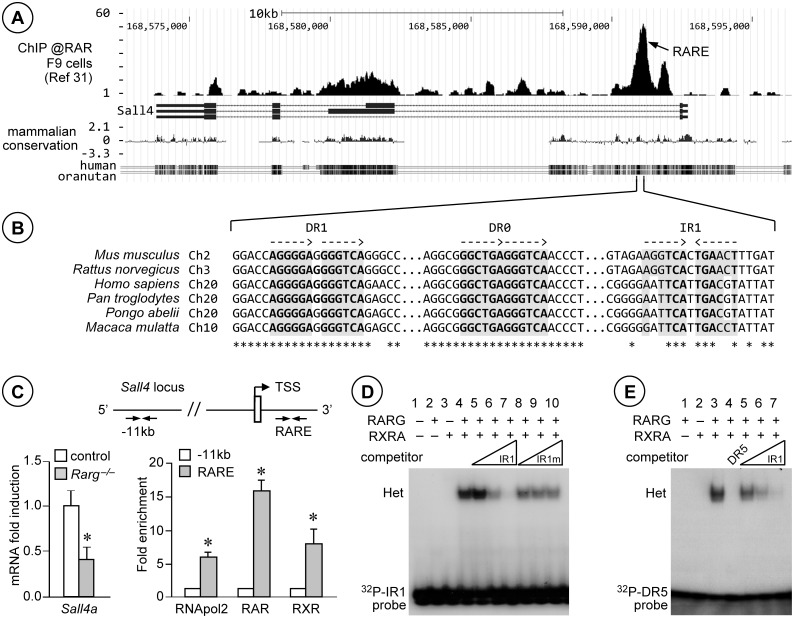
RARG/RXRA heterodimers bind to Sall4 in testis chromatin, on an IR1 motif located in the first intron.(A) UCSC Genome Browser snapshot of the Sall4 locus in NCBI37/mm9 assembly, including tracks for anti-RAR ChIP-seq [34], RefSeq genes and mammalian conservation (from top to bottom). RARE points to the RAR-binding region identified according to Moutier et al. [34]. (B) Alignments of the DNA sequences from the indicated species and corresponding to the region containing the RAR-binding region in mouse Sall4. The dotted arrows indicate orientations of the core motifs. Stars and grey boxes highlight the DNA residues and the RAR binding sequences that are conserved in all 6 species, respectively. (C) Left panel: relative expression of Sall4a mRNA quantified by RT-qPCR in whole testes from control (white bars) and Rarg
−/− (grey bars) mice at PN5. Error bars represent s.e.m. (n = 9); * p < 0.05. Right panel: schematic representation of Sall4 locus and analysis of DNA recovered from testis chromatin immunoprecipitated using antibodies directed against RNApol2, all RAR or all RXR isotypes (RAR or RXR, respectively). The untranslated exon and the transcription start site (TSS) are depicted by an open box and a broken arrow, respectively. The locations of primers used are indicated at −11 kb and in the RAR-binding region (RARE). Mean fold enrichment of three experiments at RARE binding site (grey bars) is relative to the amount of DNA recovered at −11 kb (set at 1, white bars). Error bars represent s.e.m. (n = 4 to 5); * p < 0.05. (D) EMSA showing that RARG/RXRA heterodimers (Het) bind to the 32P-labelled IR1 of Sall4 (lane 4). Binding is competed when increasing amounts of unlabeled IR1 are added to reaction (lanes 5–7), but not when a mutated form IR1 is added (IR1m, lanes 8–10). 32P-IR1 probe indicates unbound DNA. (E) EMSA showing that RARG/RXRA heterodimers (Het) bound to the DR5 of Rarb (lane 3) are competed both when unlabeled DR5 (lane 4) or increasing amounts of IR1 (lanes 5–7) are added to reaction. 32P-DR5 probe indicates unbound DNA.